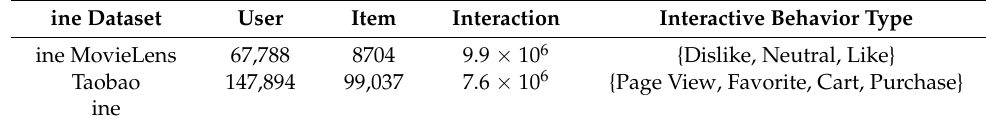
Table 1. Statictics for Taobao and